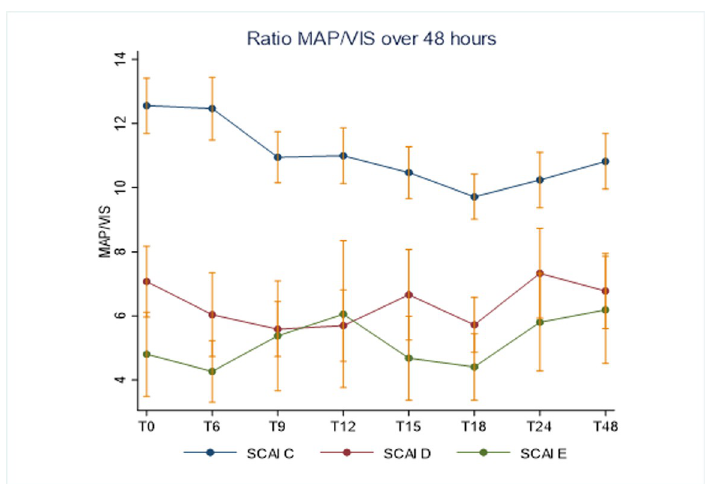
Fig 3. Ratio MAP / Vasopressor-inotropic score over 48